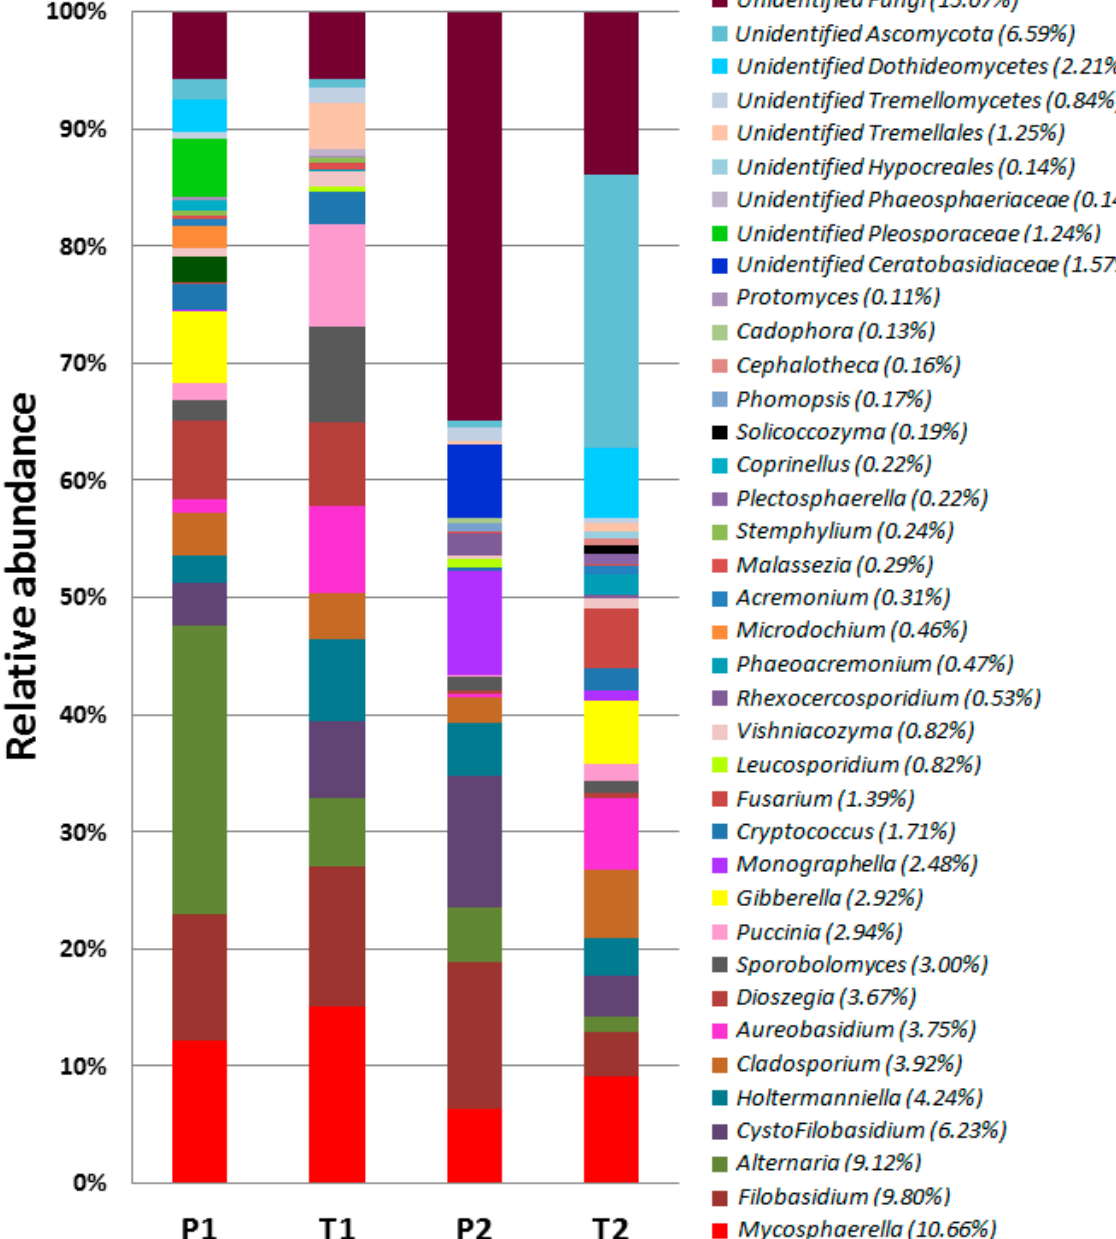
Figure 2. Endophytic fungal richness in two ancient wheat varieties. Distributions and relative abundance of the most abundant genera detected among four sample categories, from analyses of wheat sap samples. Average relative abundance for each genus is reported in paren- theses. P1 = Perciasacchi from Field 1; T1 = Tumminia from Field 1; P2 = Perciasacchi fromField 2; and T2 = Tumminia from Field 2. Mean values of relative abundance are indicated in the